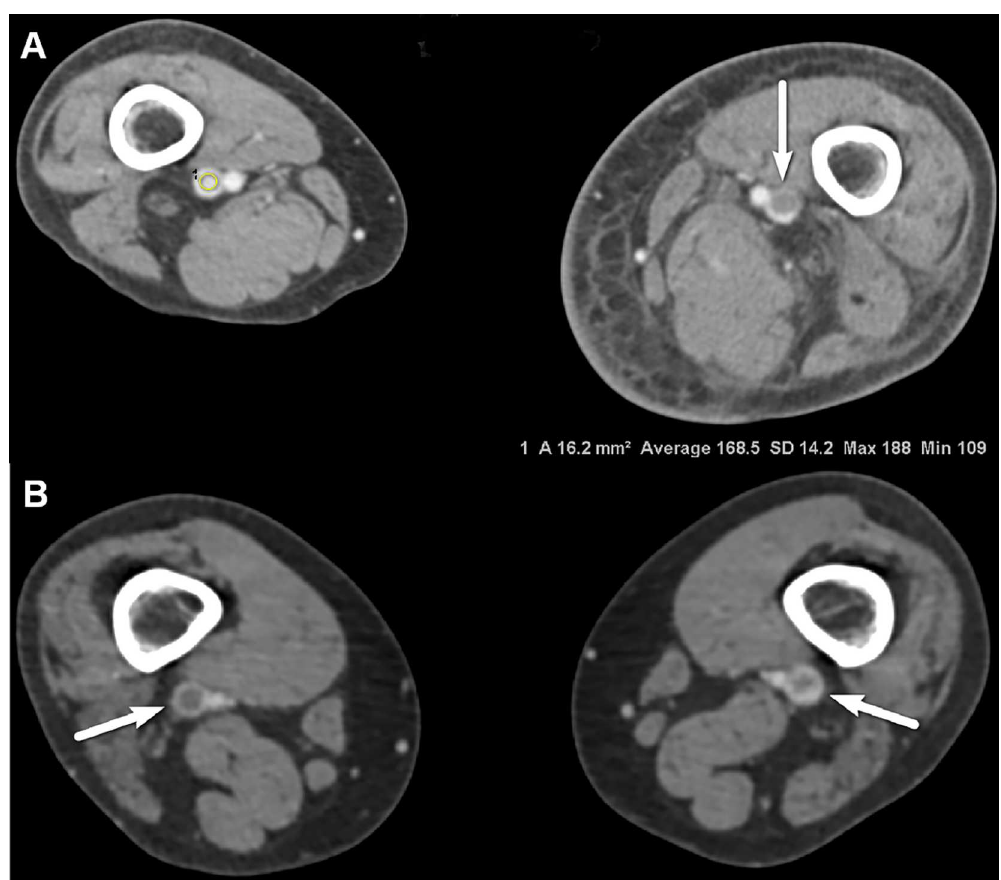
Fig 3. Comparison of axial CTV images obtained using (a) 120 kVp and FBP and (b) 80 kVp and SAFIRE from representative patient of each group (BMI 22.0 and 24.1, respectively). (a) Intraluminal filling defect (arrow) was detected in the left femoral vein, which was diagnosedas DVT. Attenuation value of right femoral vein, vein-to- muscle contrast-to-noise ratio and signal-to-noise ratio were 168.5 HU, 12.3 and 11.9. (b) Intraluminal filling defects (arrows) were detected in both femoral veins, which were diagnosedas DVT. Attenuation value of right common femoral vein, vein-to-muscle contrast-to-noise ratio and signal-to-noise ratio were 184.0 HU, 6.5 and 11.1 (figure not shown). Subjective scores for overallimage quality and image noise were 4 (good) and 1 (optimal) in (a) and 4 (good) and 1 (optimal) in (b). * CTV computed tomographic venography, FBP filtered back projection, SAFIRE sinogram-affirmed iterative reconstruction, BMI body mass index, DVT deep vein thrombosis, HU Hounsfield unit.